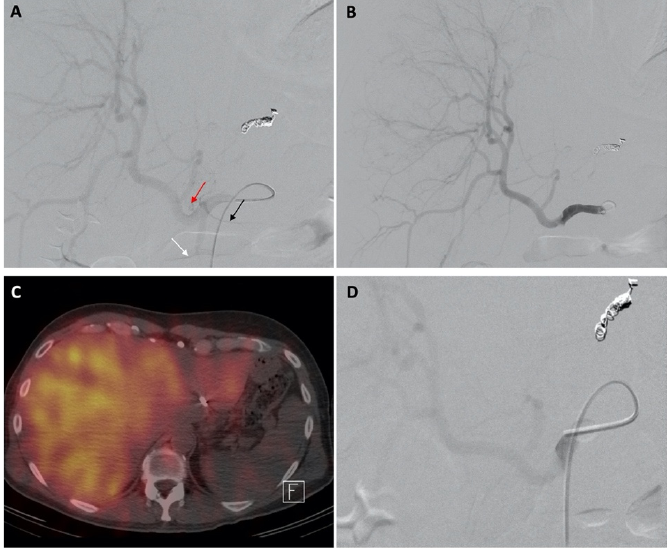
Figure 2. Images of a patient given diagnostic Tc-99m MAA injections and therapeutic 90 Y RE. Digital subtraction angiography from the celiac axis showed hepatofugal flow within the GDA (white arrow), RGA (black arrow), and supraduodenal artery (red arrow) ( A ). The accessory LHA was embolized for flow redistribution. A repeat celiac arteriogram with the balloon occlusion technique showed flow reversal in all three hepatoenteric arteries ( B ). Nuclear scintigraphy using SPECT/CT after Tc-99m MAA administration showed satisfactory distribution of it within the liver without significant extrahepatic uptake ( C ). A repeat celiac arteriogram through the inflated balloon catheter during 90 Y RE demonstrated flow reversal ( D ).